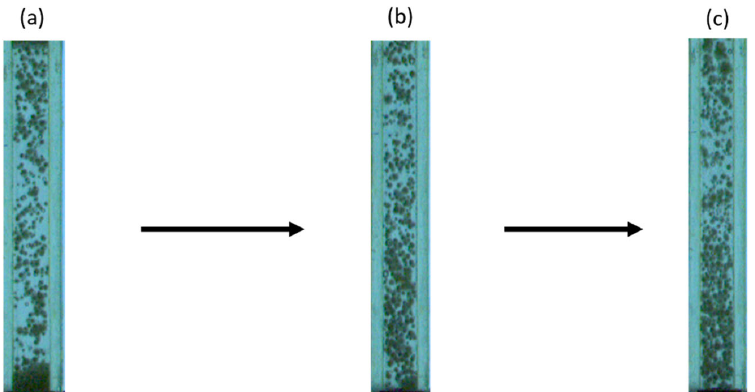
Figure 12. Representative snapshots of different flow regimes for fungal pellets fluidization with increasing gas flowrate: ( a ) Q G = 9.9 mL/min, ( b ) Q G = 22.9 mL/min, ( c ) Q G = 43.8 mL/min [40] .